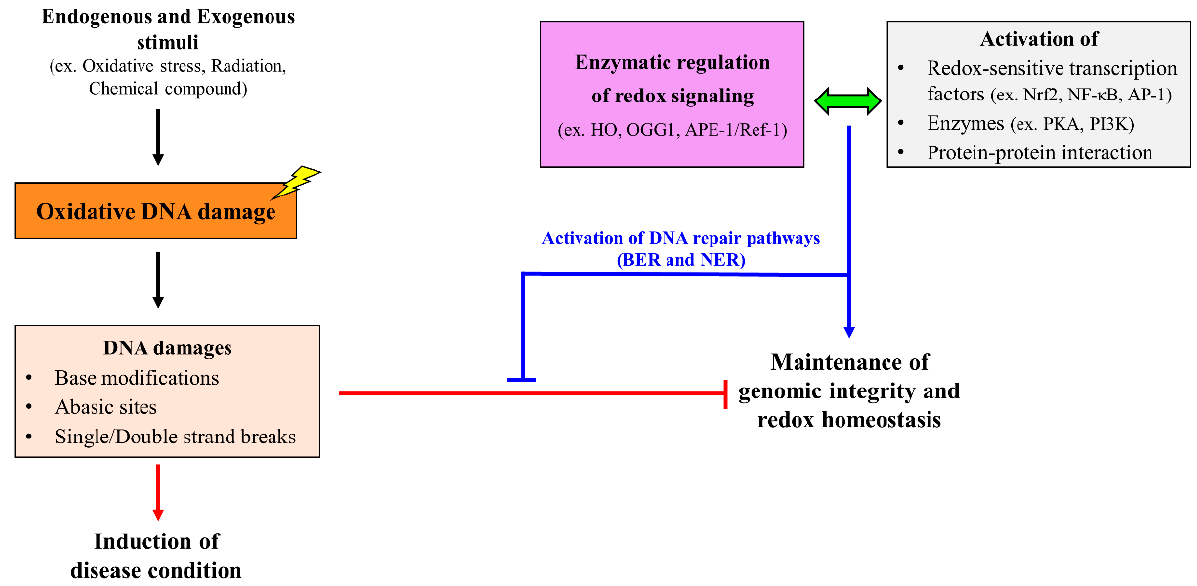
Figure 1. Enzymatic regulation of redox homeostasis and genomic integrity.